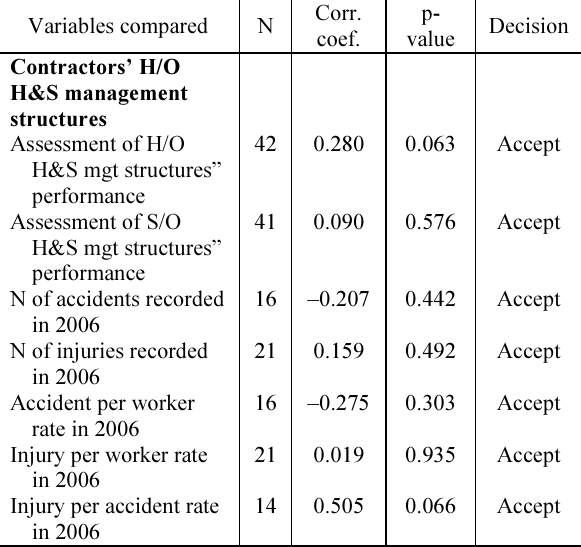
Table 4. Results of Spearman correlation between contractors’